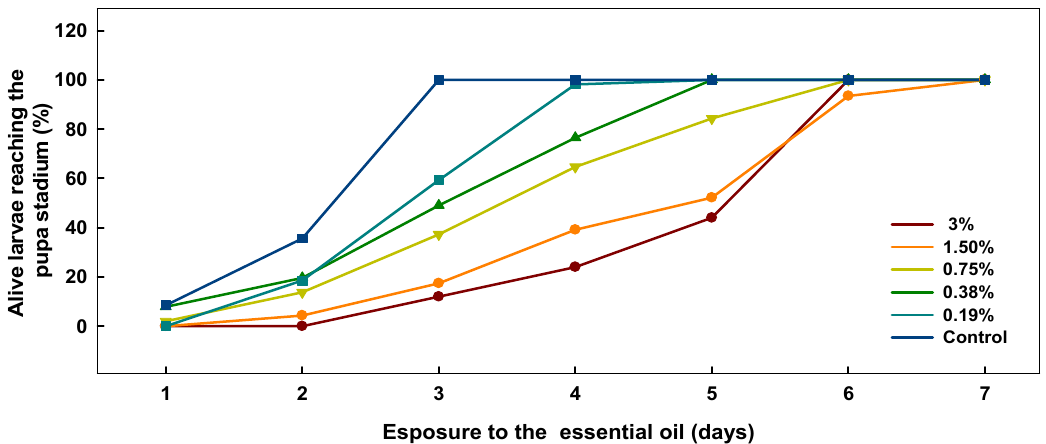
Figure 1. The effect of essential oil from rhizomes of P. hybridus subsp. ochroleucus on on the Figure 1. The e ff ect of essential oil from rhizomes of P. hybridus subsp. ochroleucuson on the development development of D. melanogaster larvae into pupae. The effect is statically significant for each tested of D. melanogaster larvae into pupae. The e ff ect is statically significant for each tested concentration concentration when compared to the control group (Fischer's exact test p < 0.05). when compared to the control group (Fischer’s exact test p <